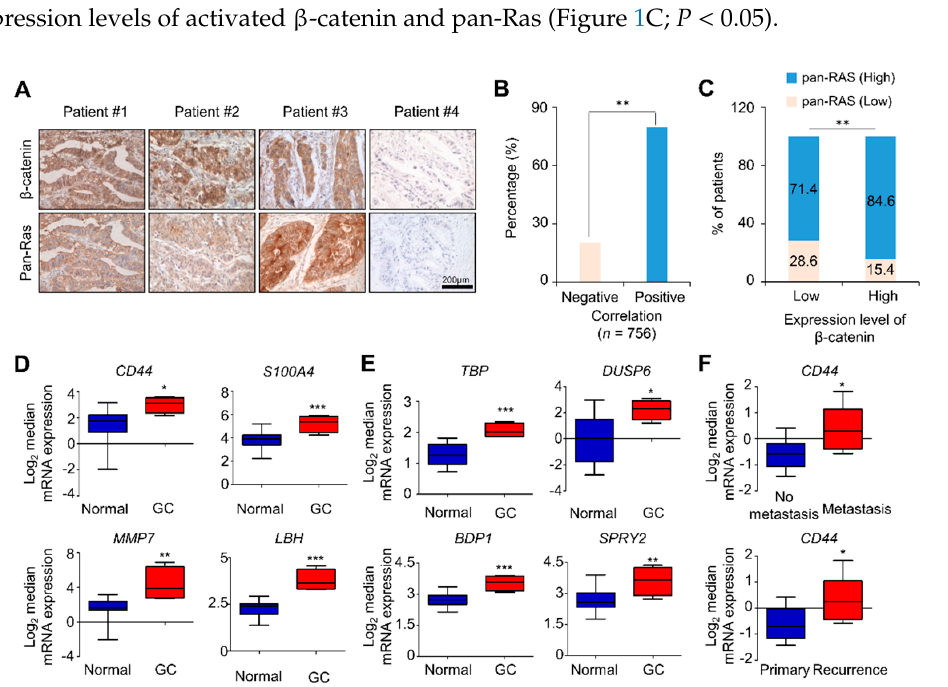
Figure 1. β -catenin and pan-RAS levels, and the expression of Wnt / β -catenin and RAS-ERK pathway target genes, including the CSC marker genes, were increased in tissues of GC patients. ( A ) Tumor tissues of 756 advanced gastric cancer (AGC) patients fixed on TMA slides were analyzed by 3,3 ′ -diaminobenzidine staining using β -catenin or pan-RAS antibody. Representative images are presented. Scale bar represents 200 µ M. ( B ) Correlations of the expression levels of pan-RAS and β -catenin in 756 AGC tissues are presented as percentages ( P < 0.01). ( C ) Correlations of the expression levels of pan-RAS and β -catenin are presented on the basis of high and low patterns of these markers ( P < 0.01, chi-squared test; comparing β -catenin low versus high). ( D – E ) Oncomine analysis of the DErrico database for the mRNA expression of Wnt / β -catenin ( CD44 , S100A4 , MMP7 , and LBH ) and RAS-ERK ( TBP , DUSP6 , BDP1 , and SPRY2 ) pathway target genes in GC tissues compared with normal gastric mucosa tissues ( n = 69, DErrico Gastric statistics; P < 0.05 with Student’s t -test). ( F ) Oncomine analysis for the mRNA expression of CD44 in metastatic and recurring GC patient tissues compared with non-metastatic and primary tumor tissues, respectively ( n = 43, Forster Gastric statistics; P < 0.05 with Student’s t